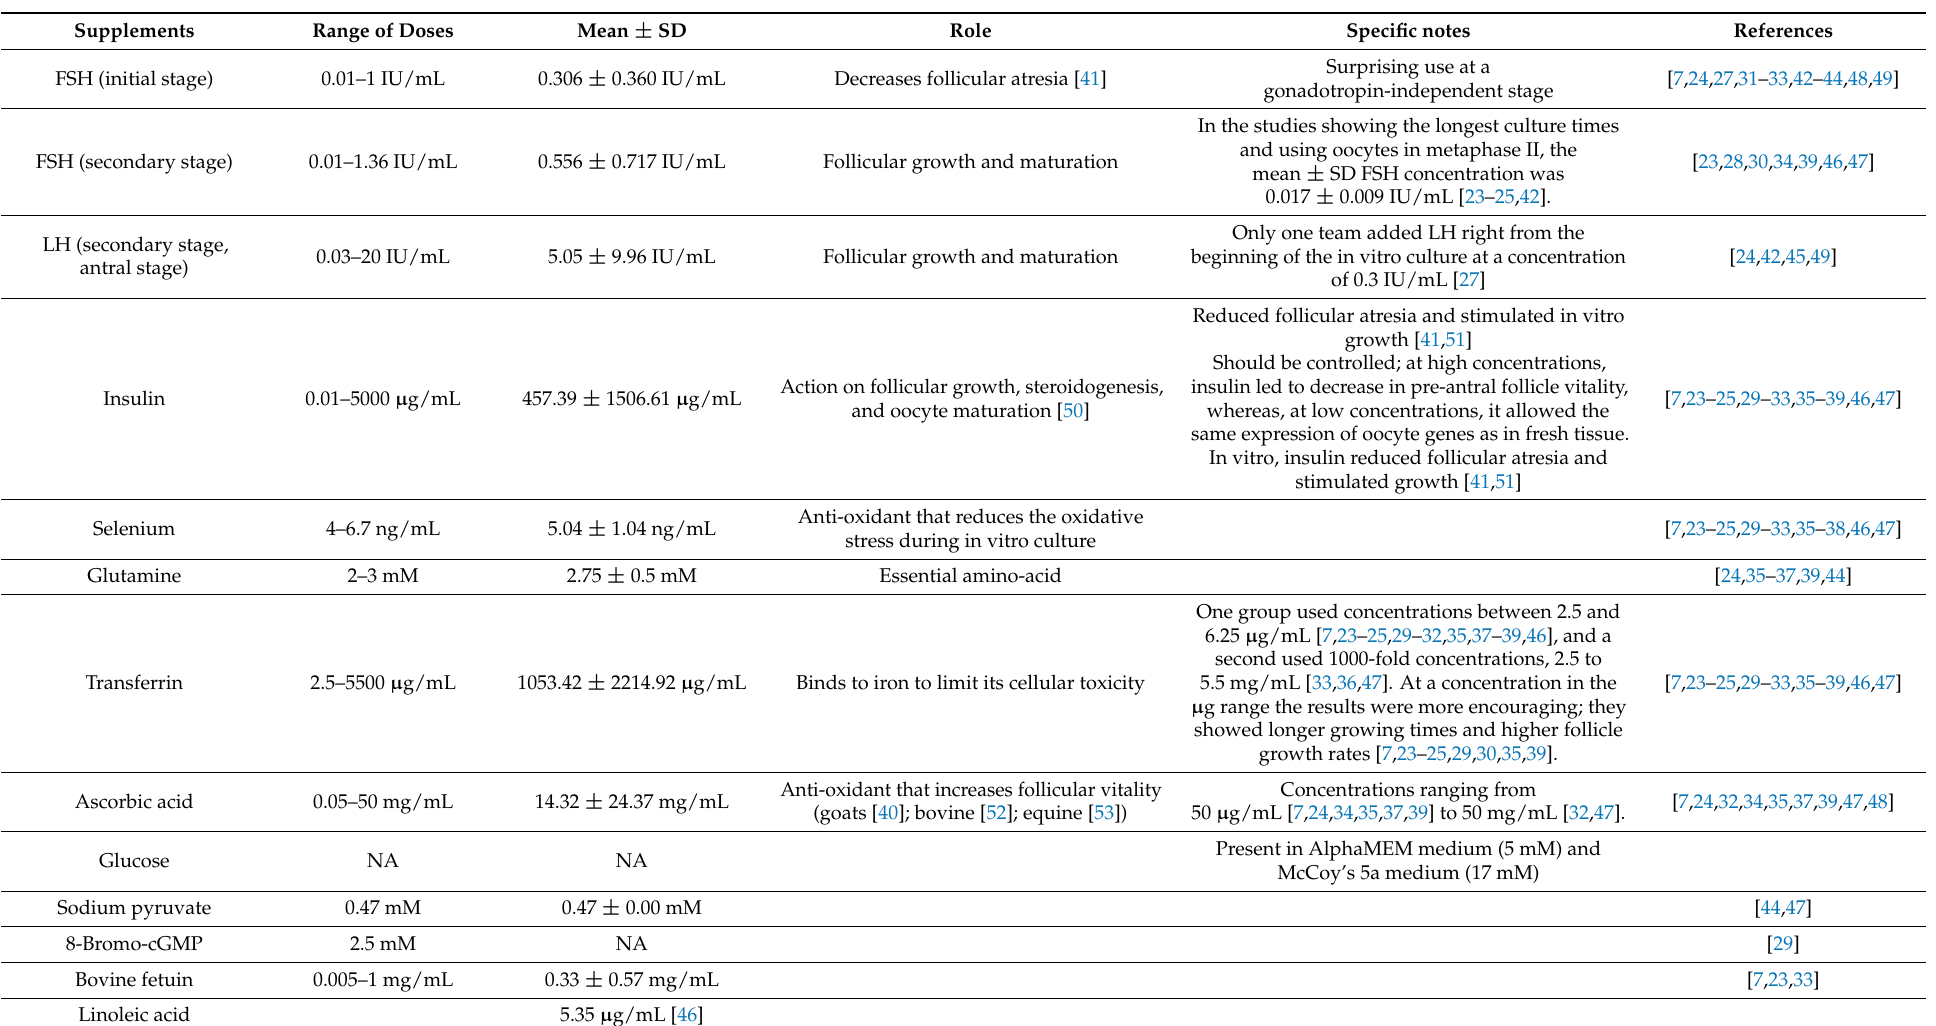
Table 1. Summary of the different culture media